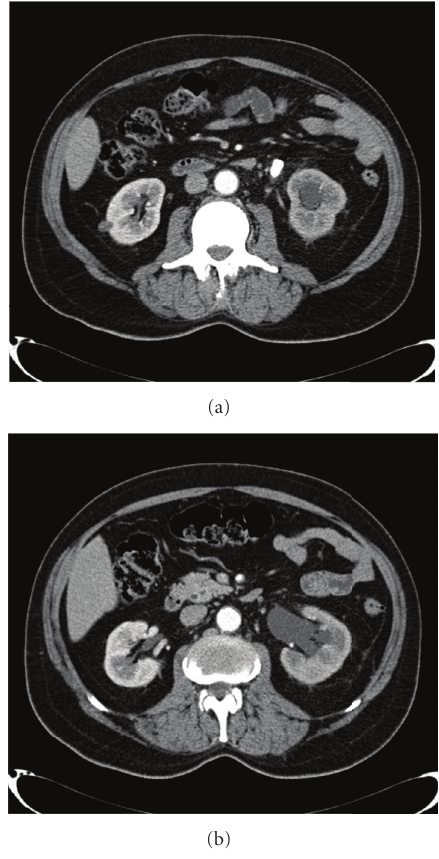
Figure 2: (a) Abdomen CT scan: left ureteral stone. (b) Abdomen CT scan: left hydronephrosis.